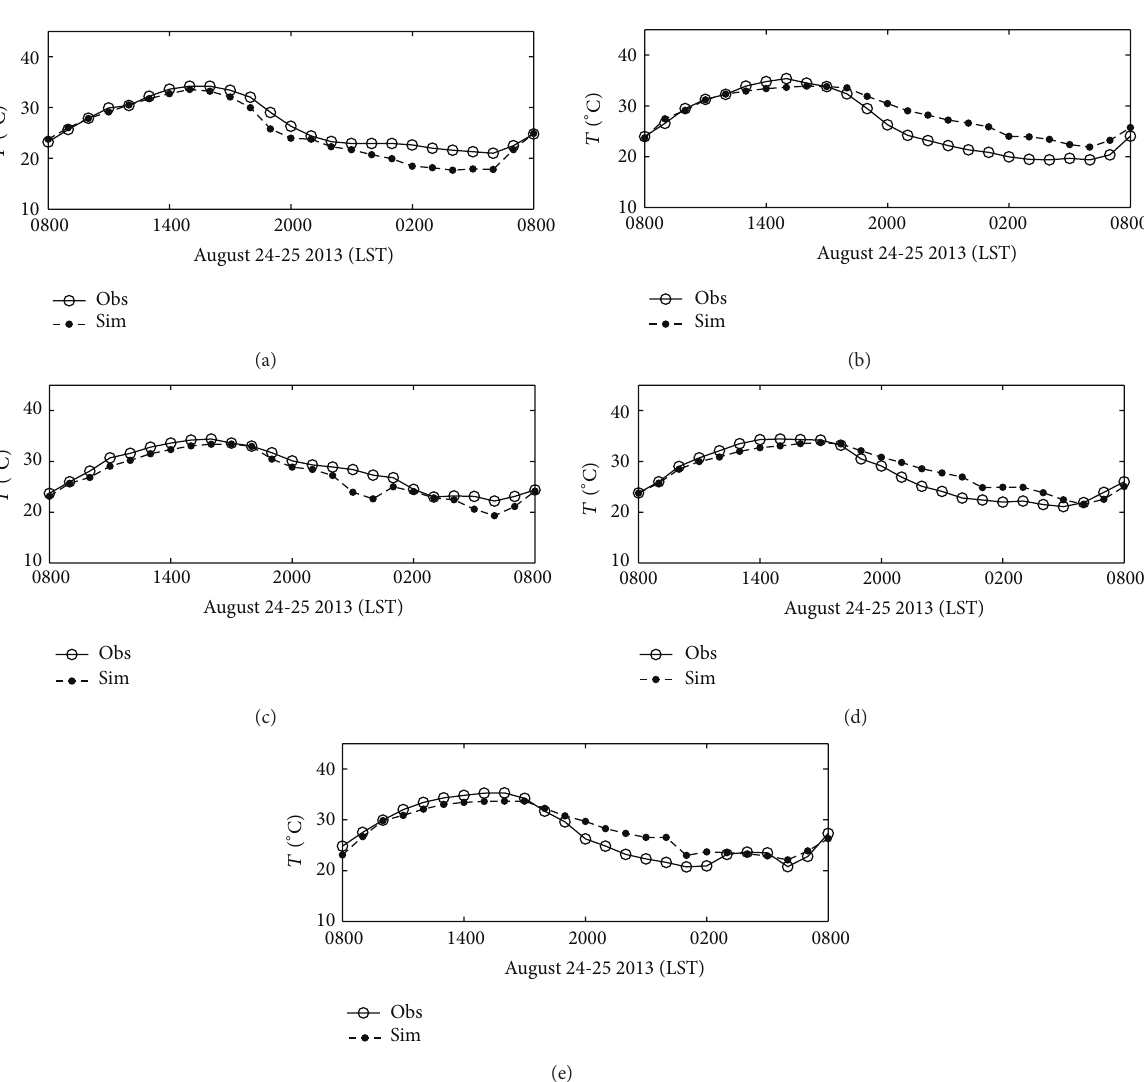
Figure 2: Time series of observed and simulated 2 m temperature ( ∘ C). (a) Shunyi, (b) Haidian, (c) Tongzhou, (d) Chaoyang, and (e) Fengtai. The simulations are obtained from the grids nearest to the stations.